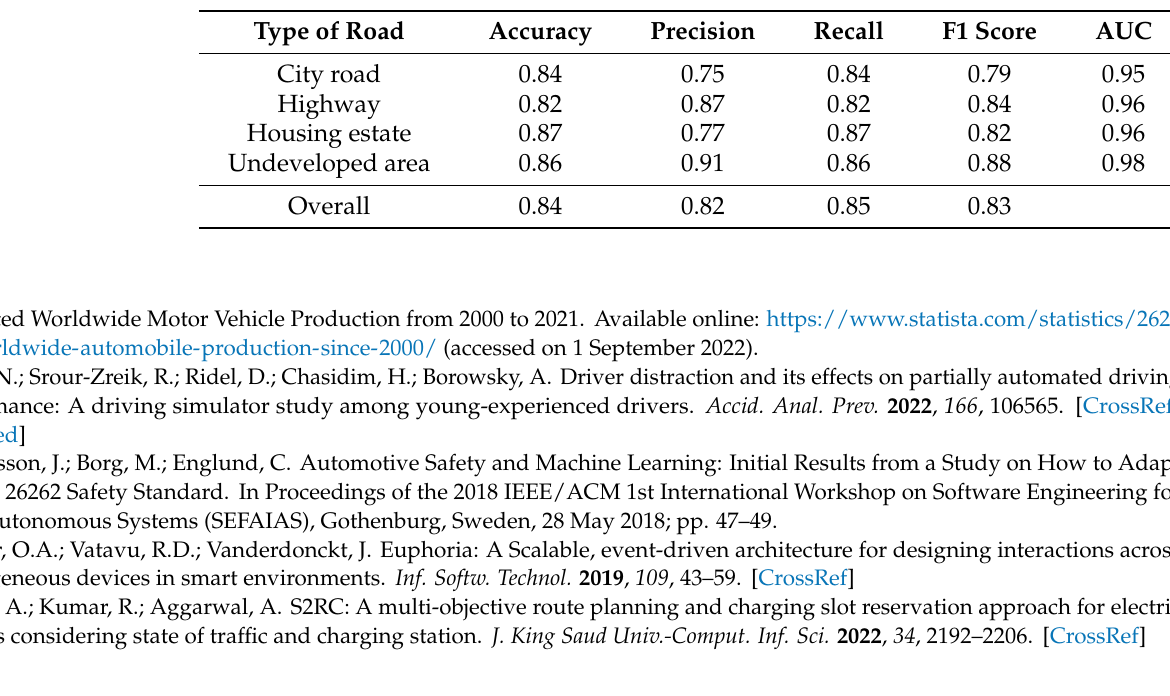
Figure A8. ROC curves of the ensemble classifier. Table A4. Evaluation metrics of the ensemble classifier on the test